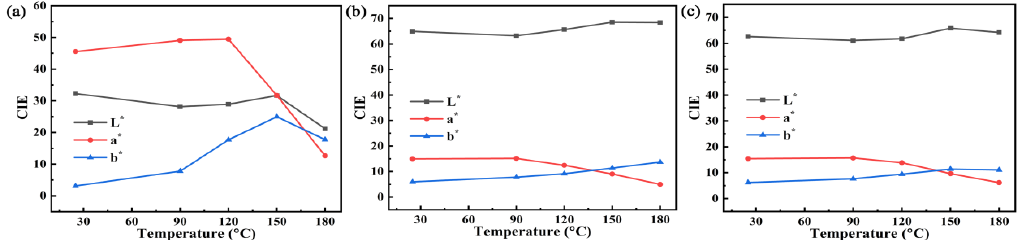
Figure 6. CIE of ( a ) betanin, ( b ) betanin/Pal and ( c ) betanin/Hal at different temperatures.